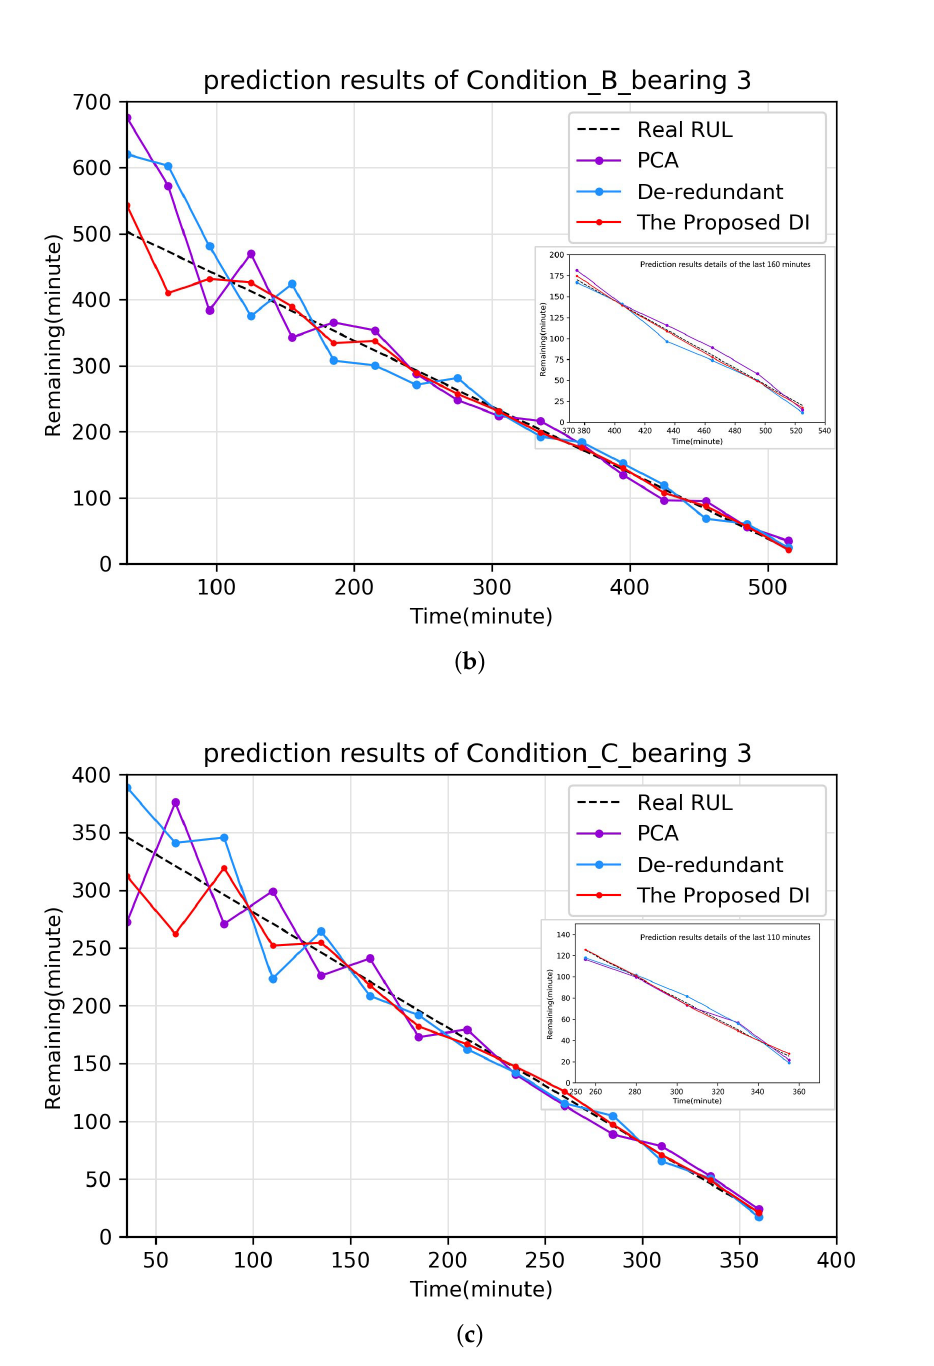
Figure 13. Deterministic point prediction results based on different DI method. ( a ) deterministic point prediction results of bearing 3 under working condition A, ( b ) deterministic point prediction results of bearing 3 under working condition B, ( c ) deterministic point prediction results of bearing 3 under working condition